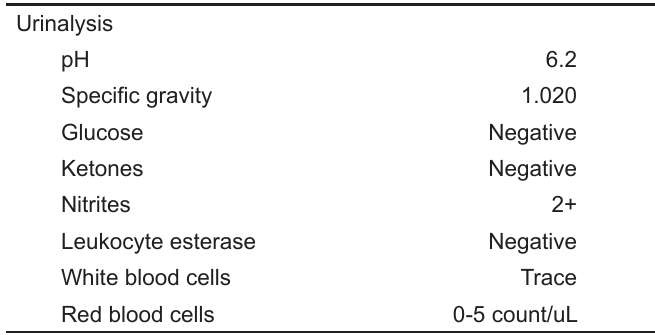
Table 2. Chemistry results. Table 3. Urinalysis results.